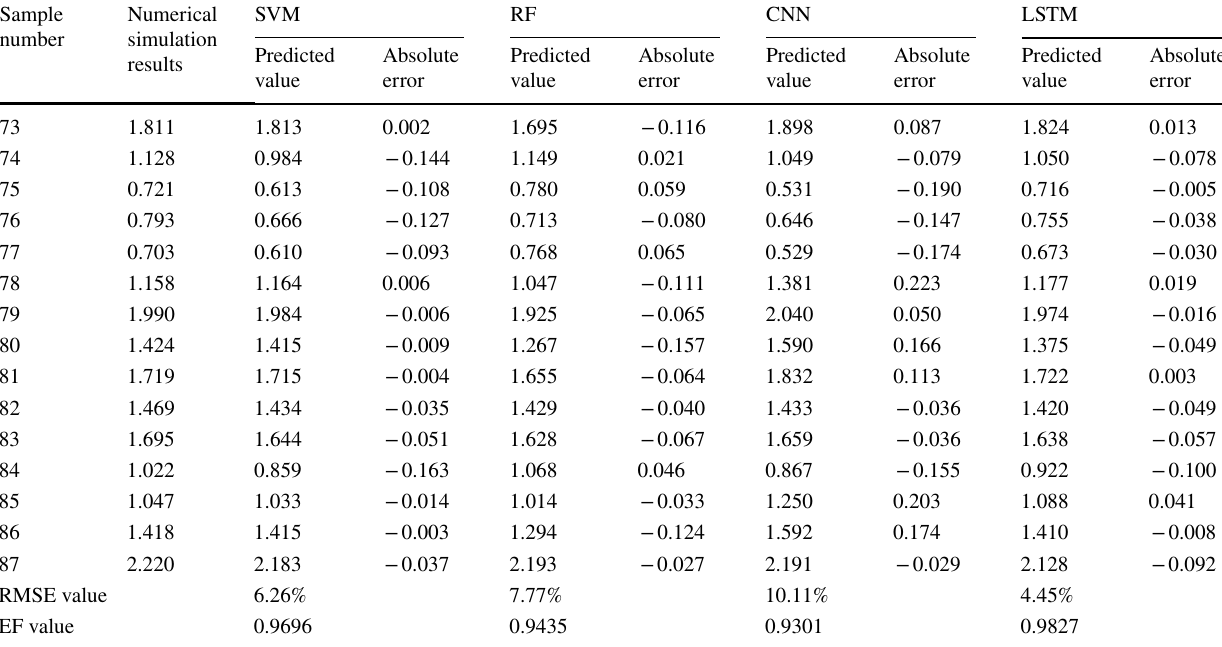
Table 4 Comparison of various model prediction results